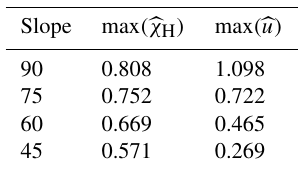
Table 3. Maximum Hayhurst stress and velocity for calving front slope experiments.